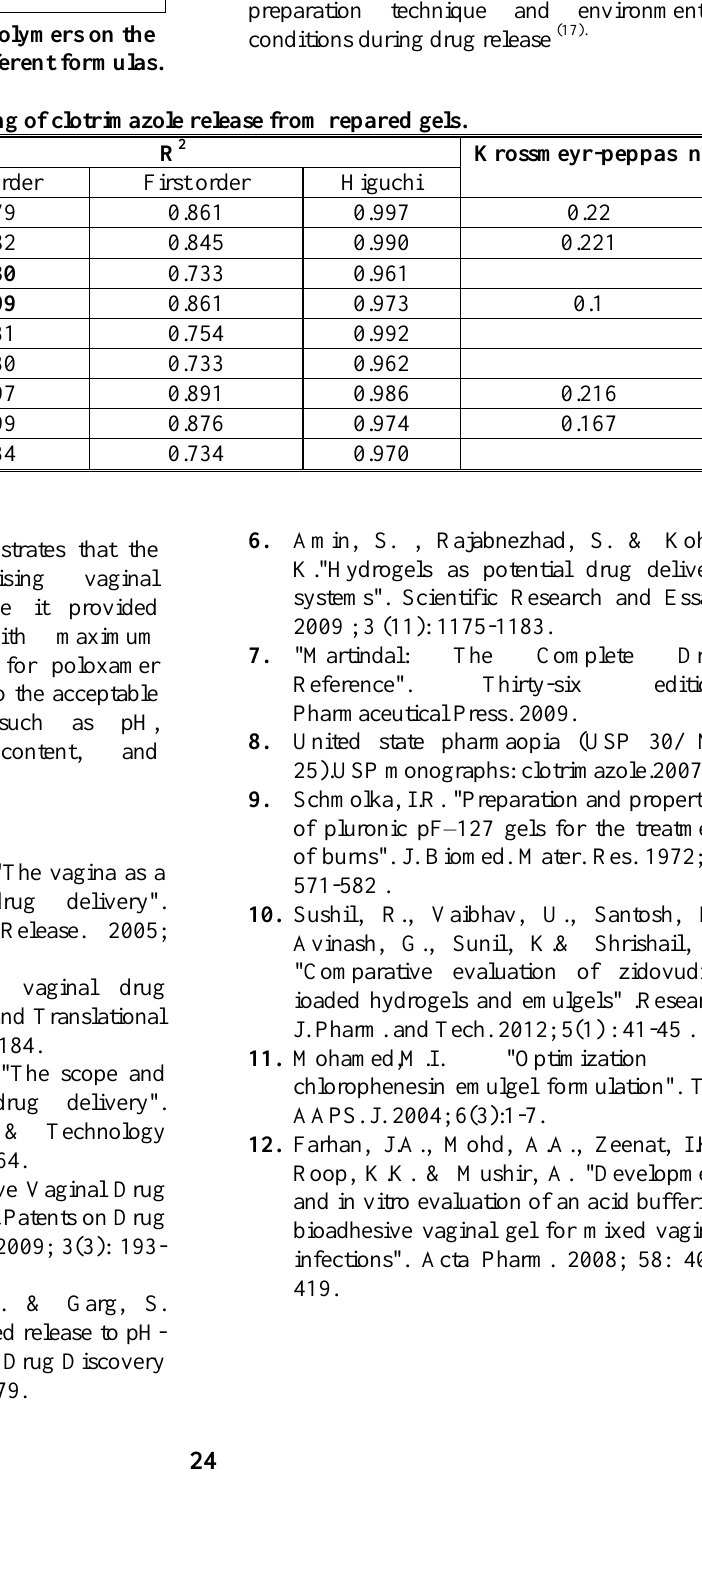
According to the results obtained and shown in table (7), the release of CLO from for release kinetic as there (R 2 )values gave high results, while F4, F7, and F8 follow zero-order kinetics. The mechanism of release depending on the composition of hydrogel, geometry, preparation technique and conditions during drug release (17).